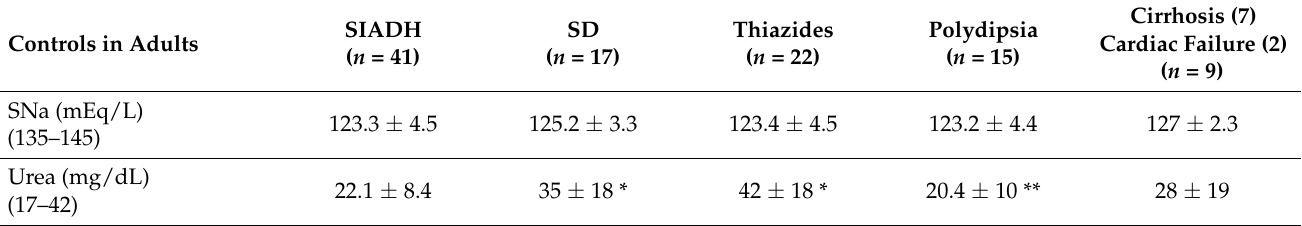
Figure 1. Evolution of the UCa/UCr ratio before and after correction of hyponatremia of different origins (the horizontal line represents the upper normal limit obtained in adults before breakfast). Table 1. Some morning biochemical data in patients with hyponatremia secondary to syndrome of inappropriate secretion of antidiuretic hormone (SIADH), to salt depletion (SD), to thiazides, to polydipsia and to hypervolemia (cirrhosis/cardiac